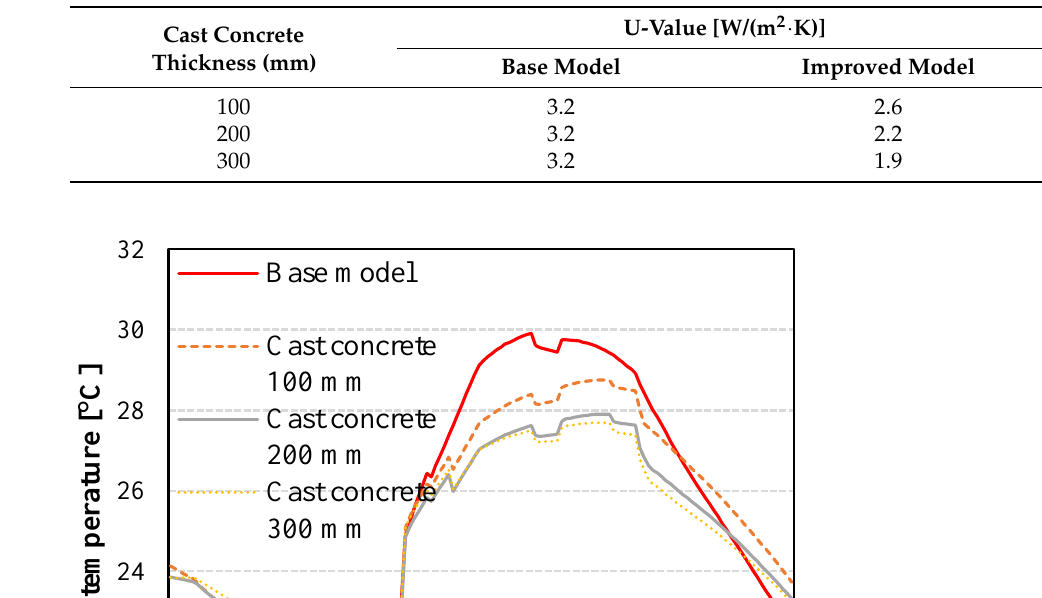
Table 11. Thermal mass applied to the base case and their thermal properties.